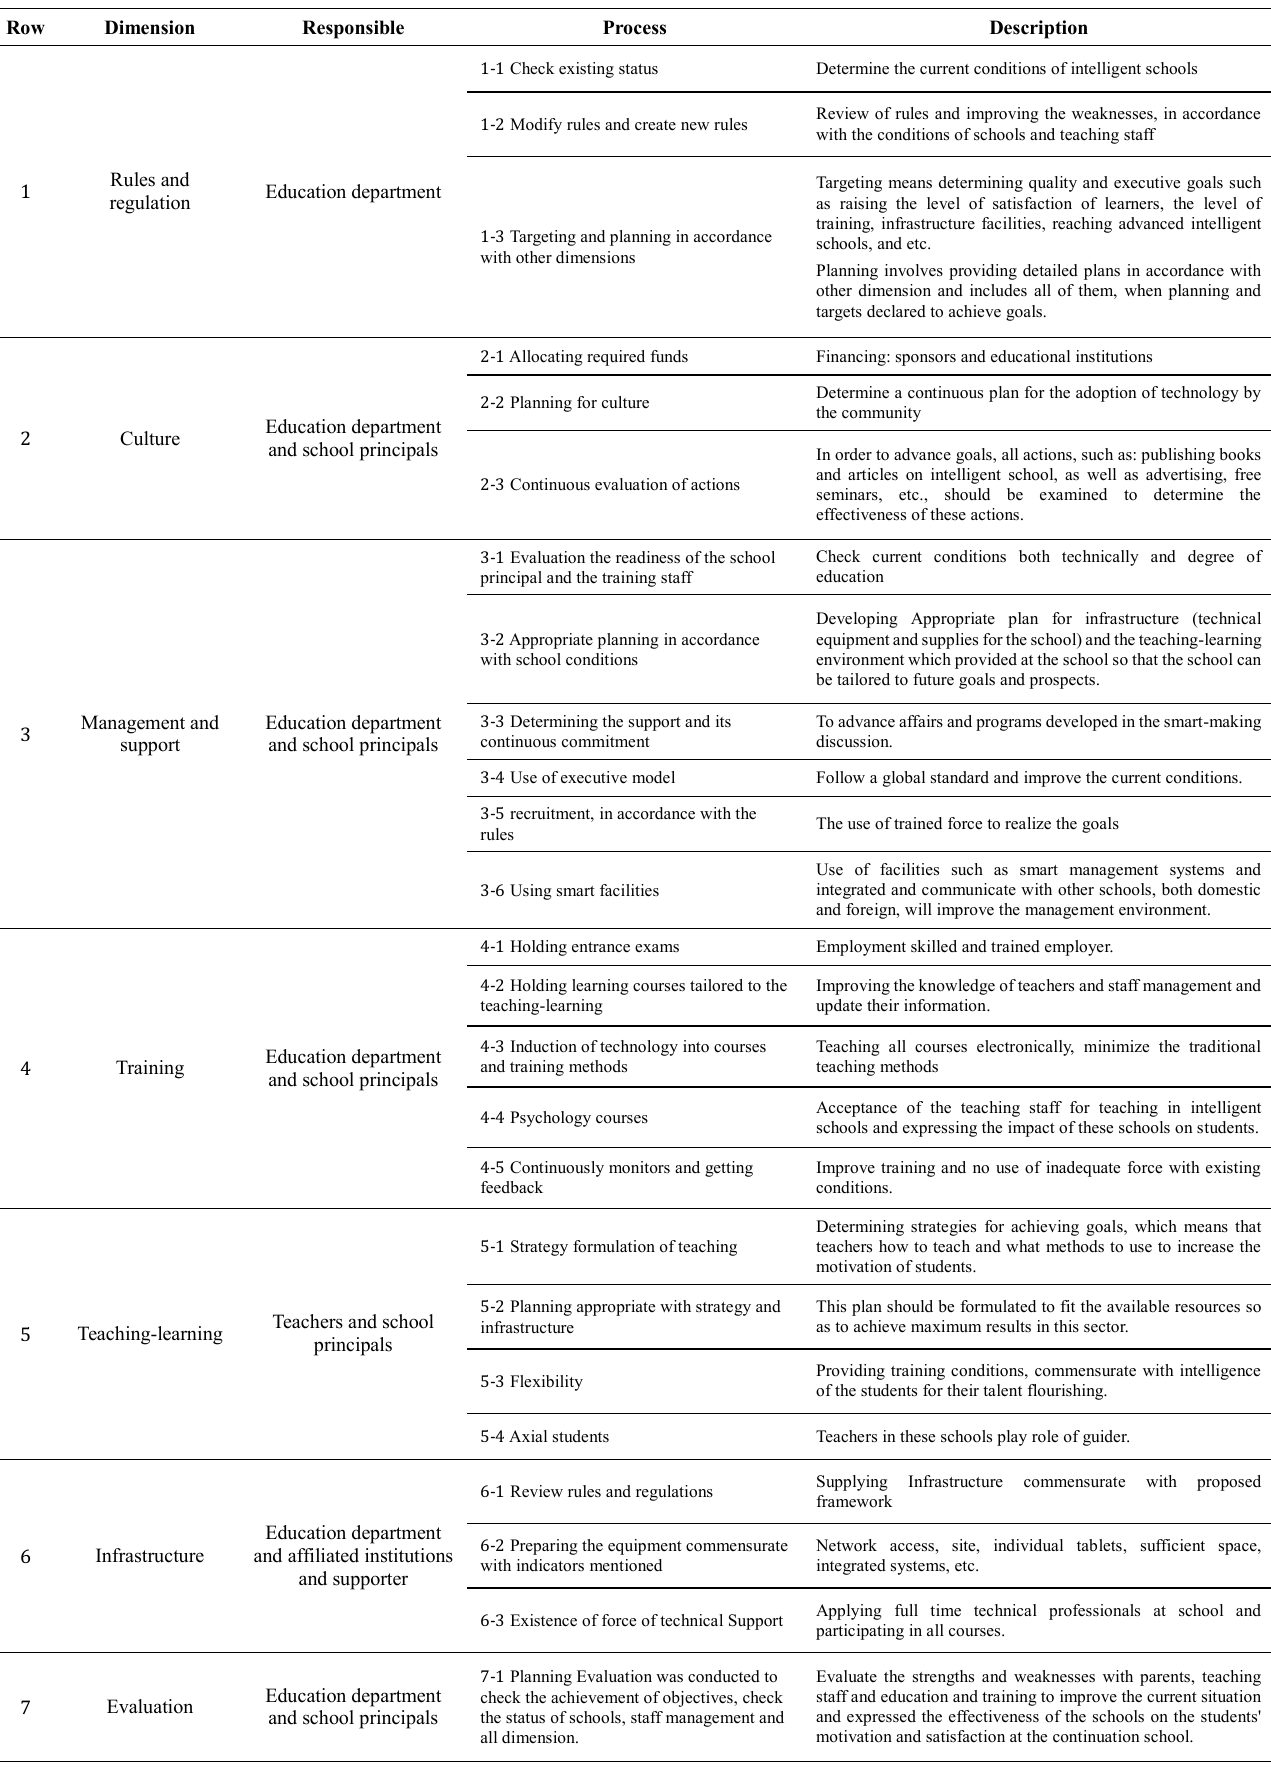
Table 8. The map of proposed model's